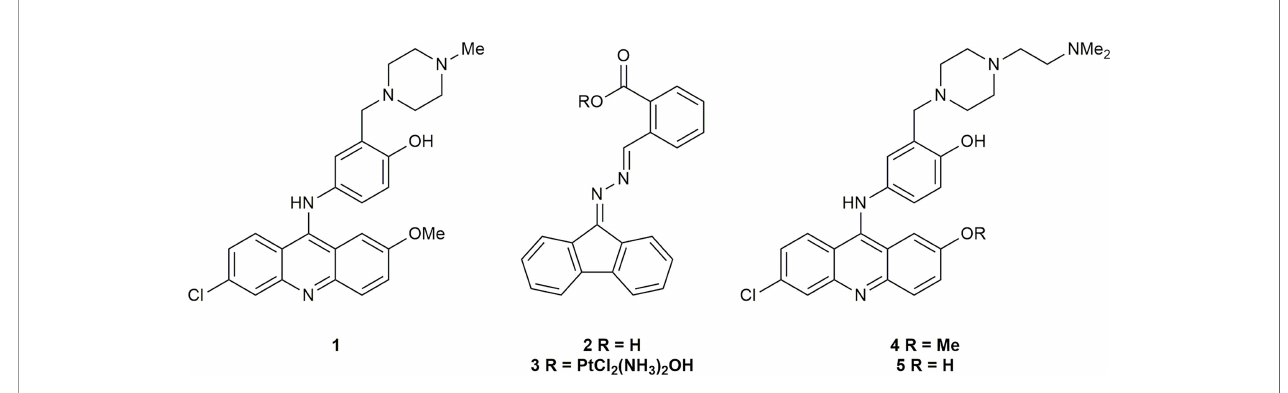
FIGURE 1 | Previously reported inhibitors of ERCC1-XPF heterodimerization.